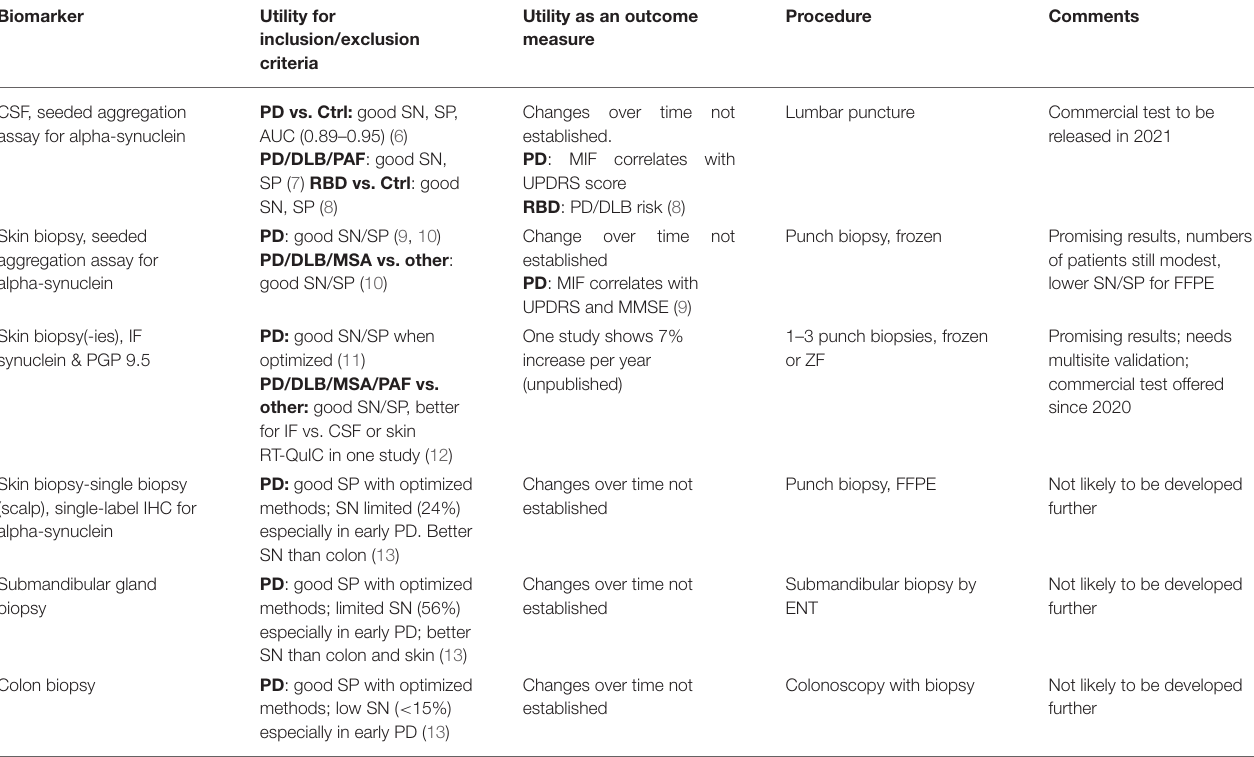
TABLE 1 | Fluid and tissue biomarkers of alpha-synuclein pathology.